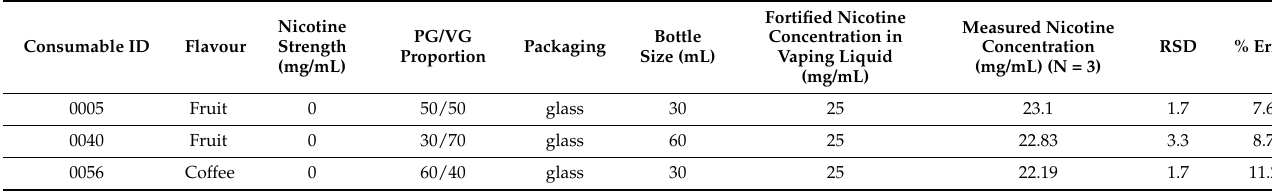
Table 1. Nicotine-free vaping liquids fortified at 25 mg/mL.